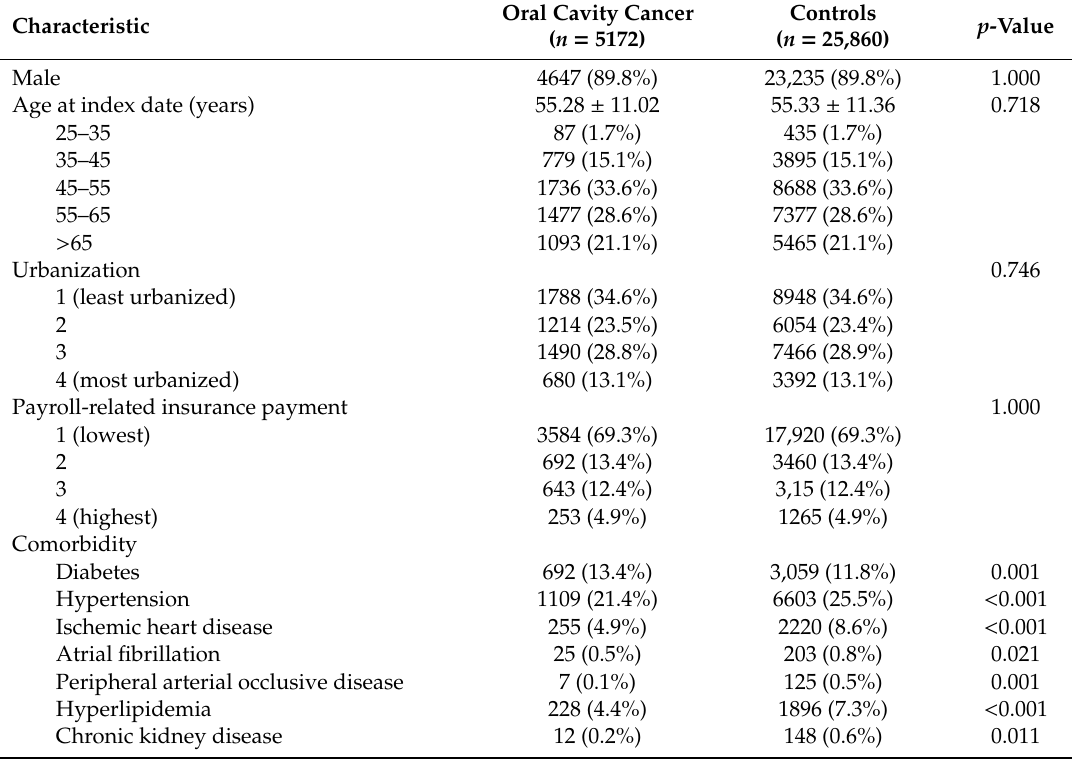
Table 1. Characteristics of the oral cavity cancer survivors and matched